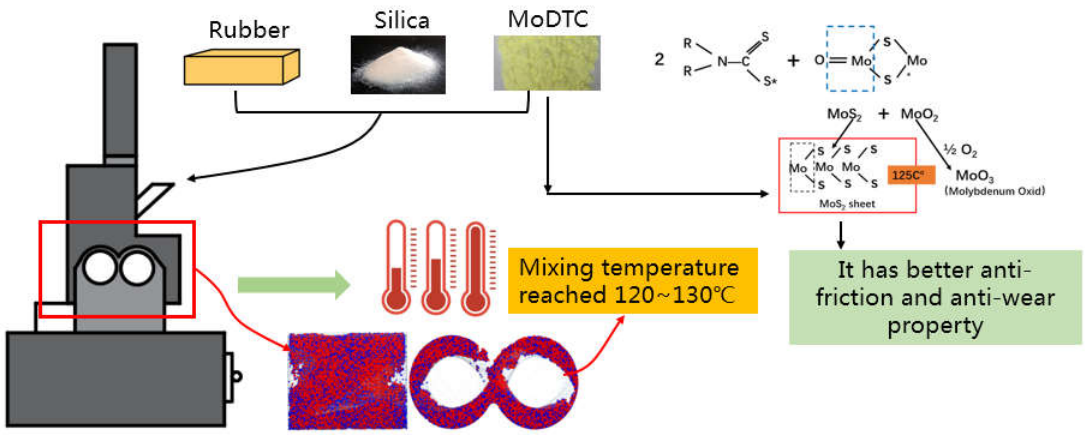
Figure 1. The chemical reaction process and interfacial lubrication products.